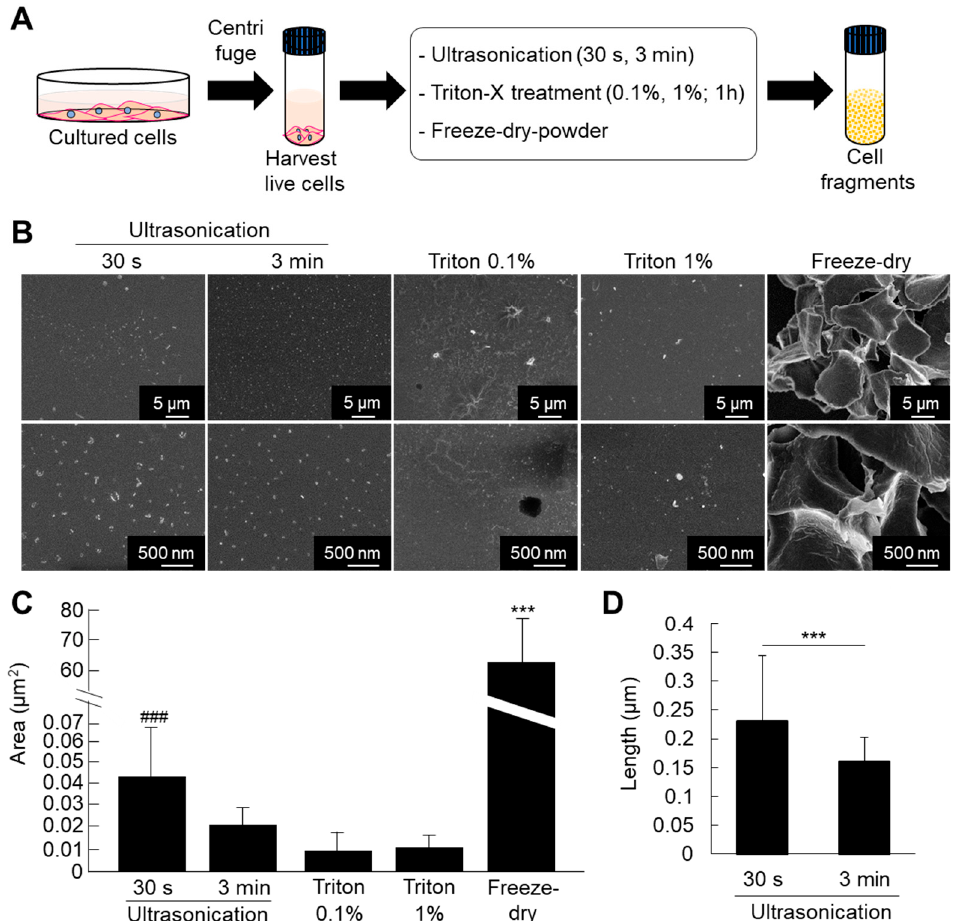
Figure 1. ( A ) Protocol for fabrication of cell fragments by mechanical and chemical methods. ( B ) Ultrastructural analysis of the cell nanofragments obtained by mechanical and chemical disruption of ATDC5 cells, observed by SEM. Note that the cell nanofragments obtained by ultrasonication for 3 min were smaller and more homogenous compared to those obtained by ultrasonication 30 s. Triton-treated (0.1% and 1%) samples showed a thin film-like structure. Freeze-dried powder fragments were large, at the micrometer level. ( C ) Graph shows the quantitative analysis of the average area ( µ m 2 ) of the fragments. Note the high standard deviation in the cell nanofragments obtained by ultrasonication 30 s and freeze-dried powder, representing the heterogeneity of the cell fragment size. *** p ≤ 0.001, ANOVA, Bonferroni post-hoc test. Freeze-dried powder samples were significantly larger than all other samples. The size of the cell nanofragments obtained by ultrasonication 30 s was significantly larger compared to ultrasonication 3 min or triton treatments. ### p ≤ 0.001, ANOVA, Bonferroni post-hoc test, excluding the freeze-dried powder group in the analysis. ( D ) Graph shows the quantitative analysis of the length (nm) of the cell nanofragments obtained by ultrasonication 30 s or 3 min. The cell nanofragments obtained by ultrasonication 3 min were significantly smaller than those obtained by ultrasonication 30 s. The high standard deviation of the nanofragments obtained by ultrasonication 30 s demonstrates the heterogeneity of the sample.